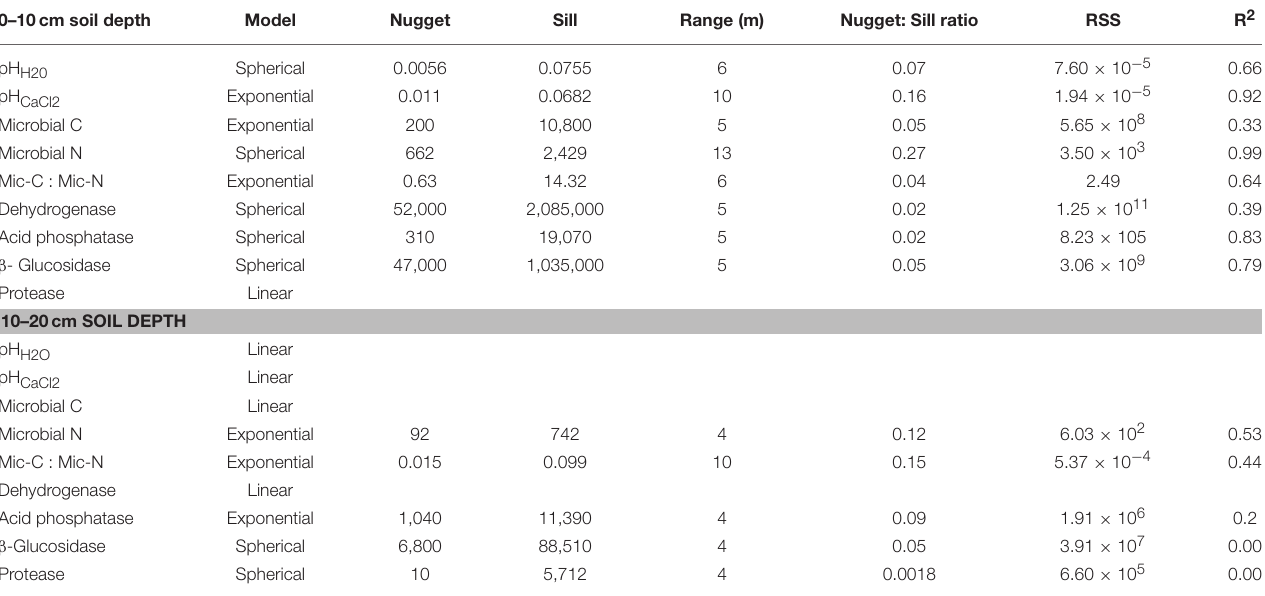
TABLE 7 | Spatial correlation of soil pH and biochemical properties in the surface and subsurface soil of a rewetted